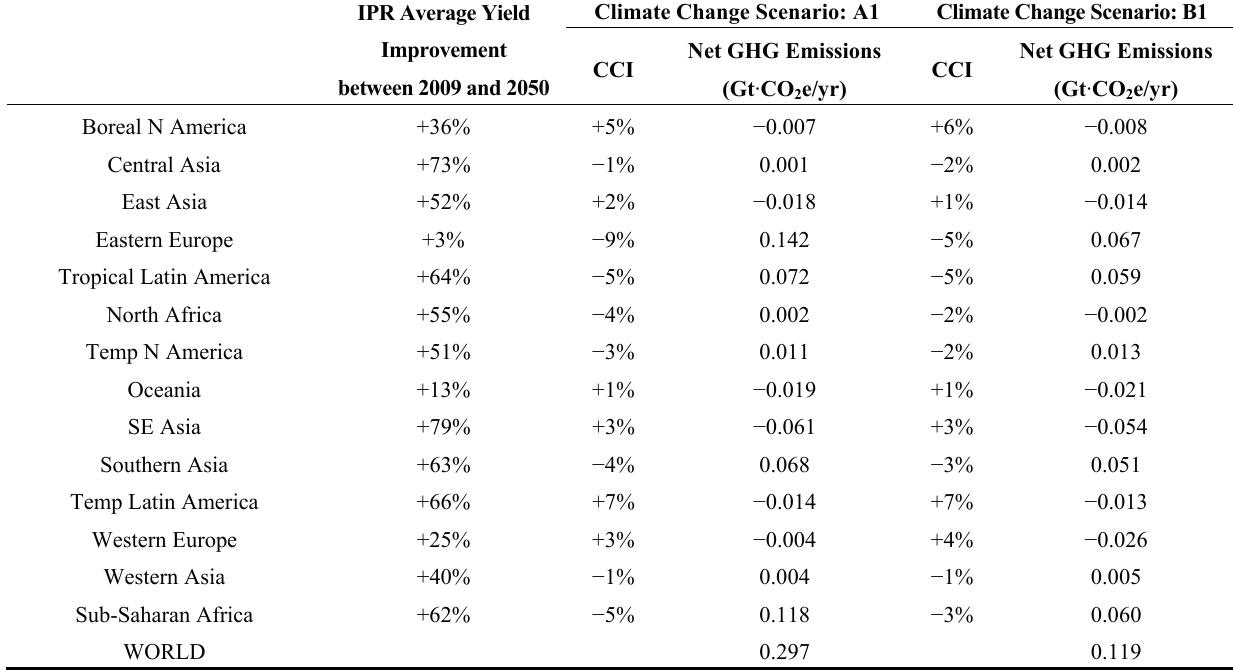
Table 2. Comparison of climate change impacts on yields in the A1 and B1 scenarios to intrinsic productivity growth rates and the resulting GHG emissions from land use change. CCI, climate change